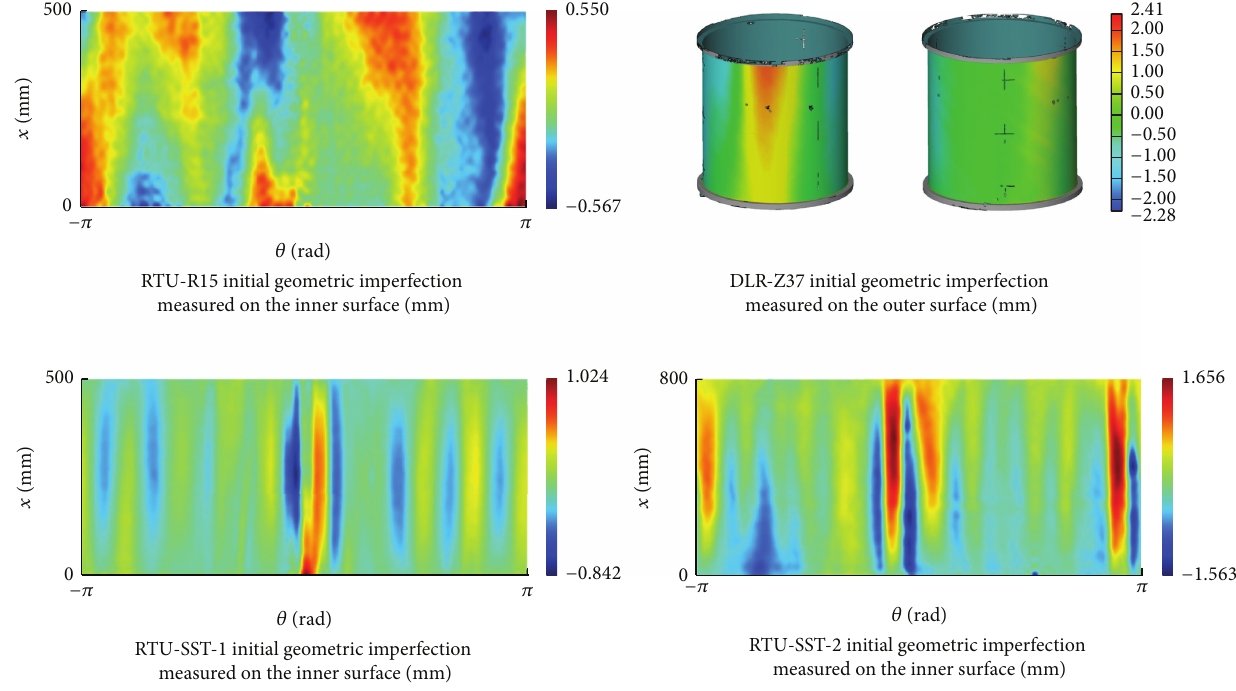
Figure 2: Initial geometric imperfection on the studied cylinders.